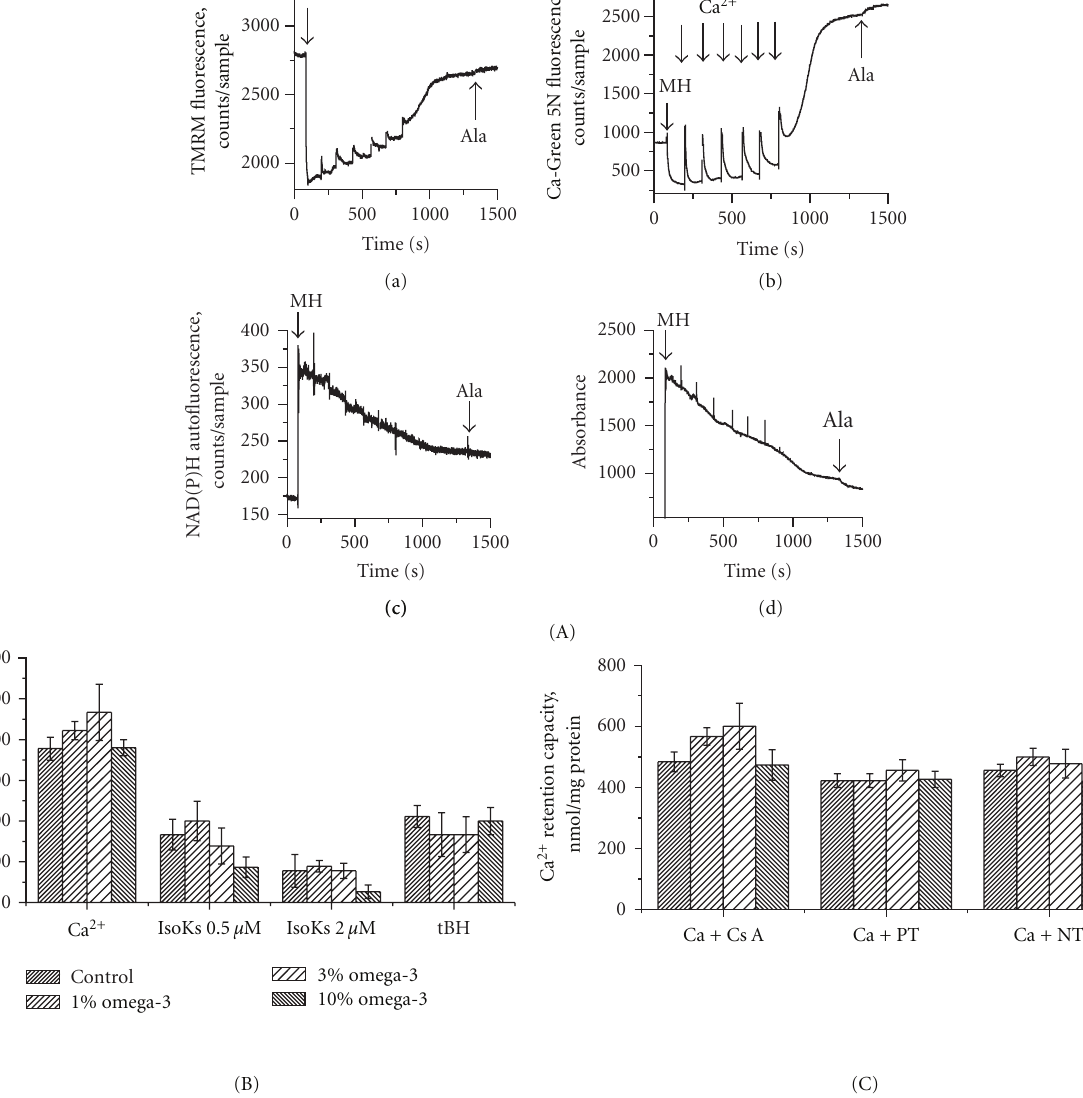
Figure 6: Omega-3 PUFA enriched diet does not change brain mitochondria Ca 2+ retention capacity. (A) Basic parameters of isolated from control rats brain mitochondria measured in the presence of the chain of Ca 2+ additions (10 μ M each addition) and 5mM glutamate/malate as a substrate. (a) Mitochondrial ΔΨ was measured as changes in TMRM fluorescence signal. Addition of mitochondria into incubation bu ff er, indicated by arrow, induced the drop of TMRM signal (i.e., TMRM concentration in the bu ff er) due to the accumulation of the dye by mitochondria. The addition of Ca 2+ induced an increase of TMRM signal, which corresponds to lower ΔΨ , and a subsequent decrease of the TMRM signal, which indicates a restoration of ΔΨ . (b) Ca 2+ concentration in the mitochondrial suspension was measured as Ca-Green 5N fluorescence signal. A higher signal corresponds to an increase of Ca 2+ concentration in the bu ff er. (c) NAD(P)H autofluorescence signal. A lower signal corresponds to a more oxidized state of NAD(P)H. (d) Mitochondrial swelling was measured as changes in light scattering of the mitochondrial suspension. A decrease in the fluorescence signal indicates an increase in swelling. Spikes resulting from additions of Ca 2+ were manually reduced; arrows are used to indicate where these manipulations occurred. Representative traces from 6 experiments are shown. (B) CRC determined in the presence of Ca 2+ , Ca 2+ + IsoK (0.5 and 2 μ M), Ca 2+ + tBH (100 μ M); (C) Ca 2+ + Cs A (0.5 μ M), Ca 2+ + promethazine (PT) (3 μ M), and Ca 2+ + nortriptyline (NT) (3 μ M), use (B) for comparison. Glutamate/malate (5mM) was used as the substrate. The data are expressed in nmol of Ca 2+ consumed by mitochondria per mg of mitochondrial protein and are the mean ± SEM, n = 6. Statistical significance in CRC between tested samples was determined by a two-sample t